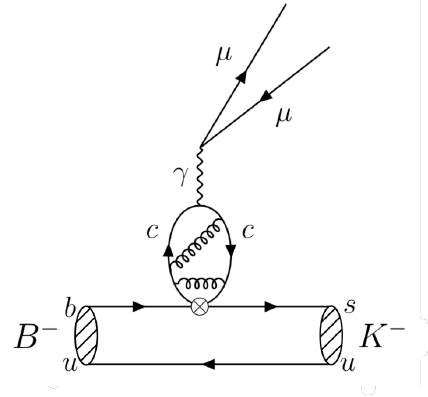
Figure 1 . Hadronic long-distance effects in B − → K − ‘ + ‘ − through a c ¯ c